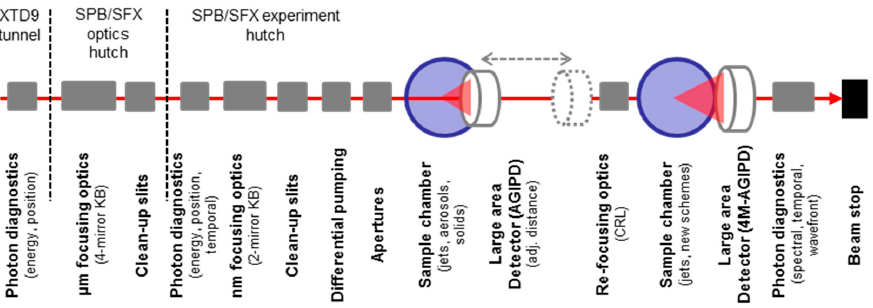
Figure 4. Overview schematic of the SPB/SFX scientific instrument at the SASE1 FEL beamline. The sketch indicates major instrumentation items installed in the photon beam transport tunnel, optics and experiment hutch. Not shown is the PP-laser instrumentation.